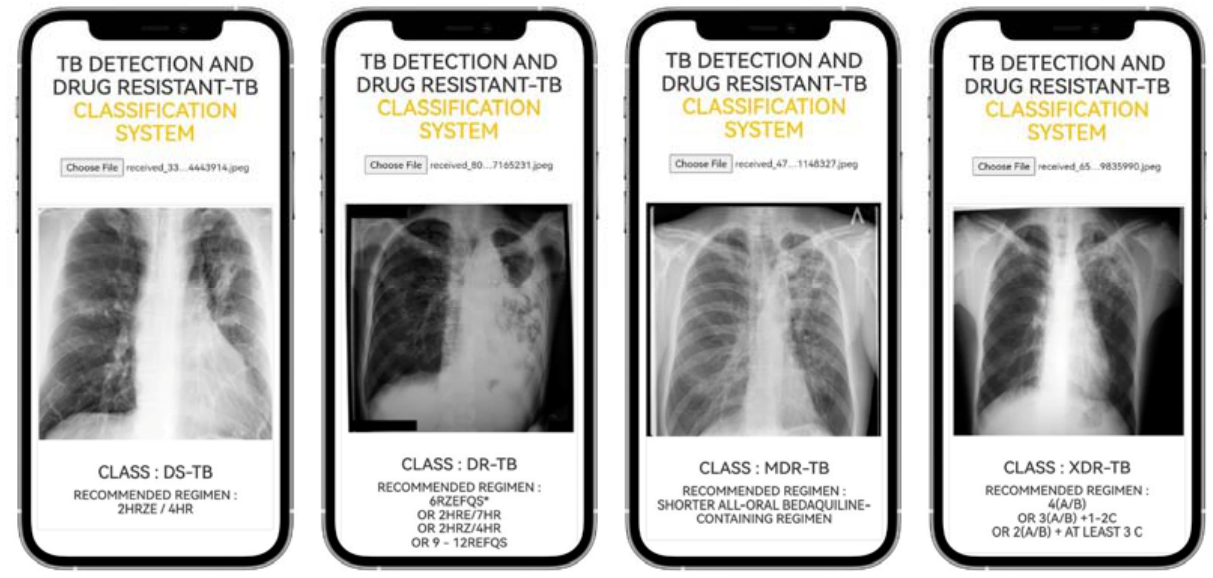
Figure 2. Example of TB-DRC-DSS User Interface.